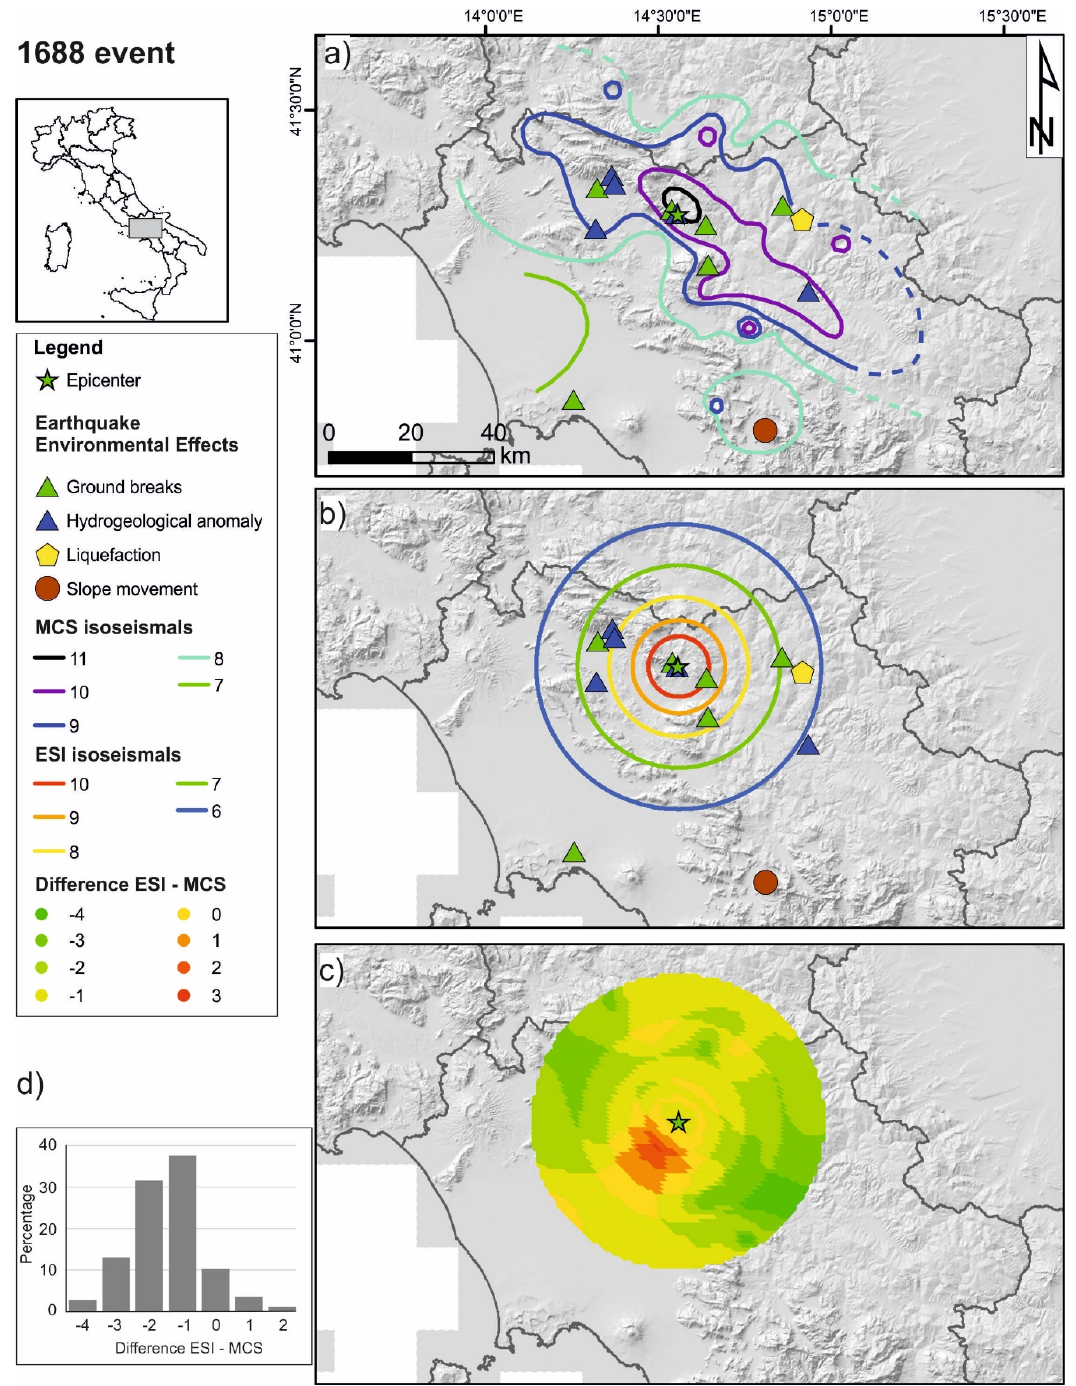
Figure 4. ( a ) map of EEEs and MCS isoseismals, dashed when inferred, of the 1688 earthquake; ( b ) map of EEEs and ESI isoseismals derived from the intensity prediction equation (IPE); ( c ) map showing the difference between ESI and MCS intensities; ( d ) histogram of the ESI-MCS difference. Inset shows, in the grey rectangle, the study area in a larger map around Italy.